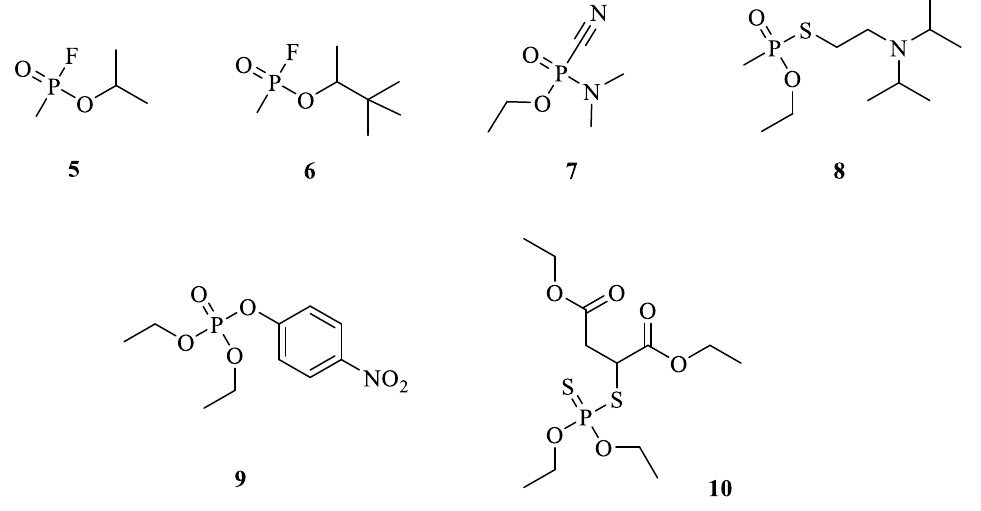
Figure 1. Toxic organophosphorus compounds.